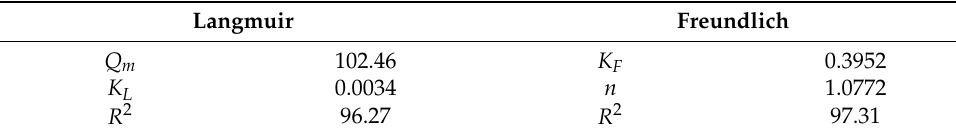
Table 2. Adsorption isotherm fitting